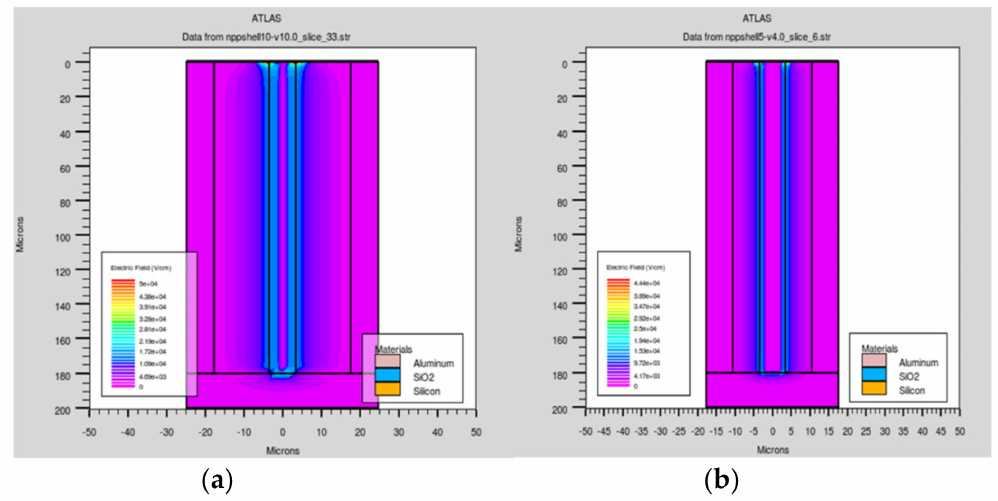
Figure 7. Electric field profiles of the detector along the X-Y diagonal with electrode spacings of ( a ) 10 µ m and ( b ) 5 µ